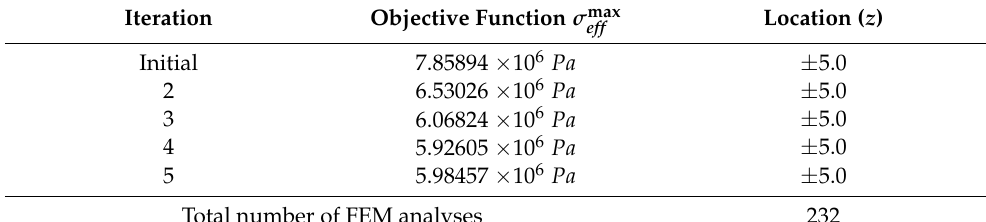
Table 3. Variation of the objective function to the iteration